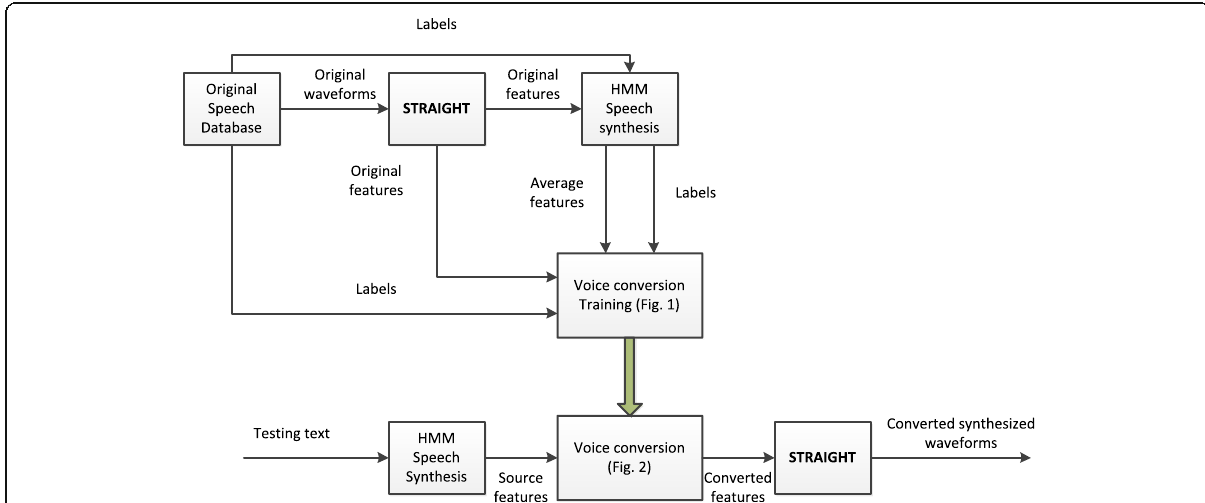
Fig. 3 Hybrid TTS between HMMSS and exemplar-based voice